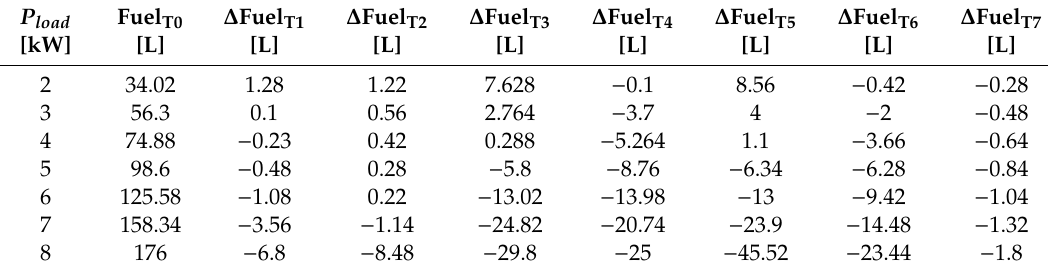
Table 4. Fuel economy for k fuel = 50 and di ff erent P load